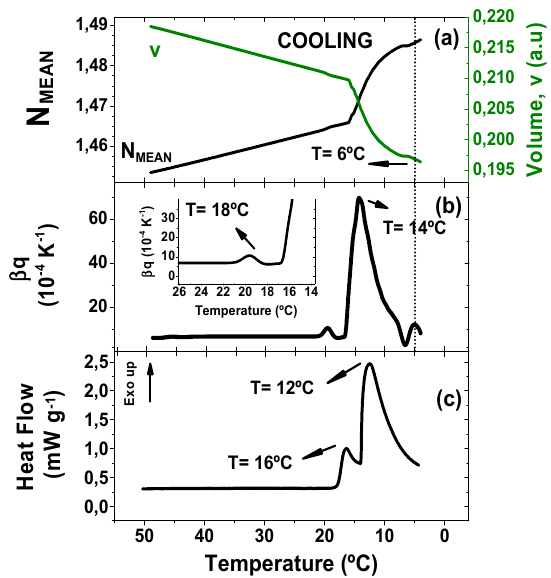
Figure 1. Comparison of the temperature dependence during cooling at 0.5 K min − 1 of ( a ) NMEAN and Volume (a.u.) recorded via TMOR with temperature modulation of 0.5 K amplitude and 17 mHz modulation frequency. ( b ) The thermal volume expansion coefficient β q (K − 1 ) recorded via TMOR with temperature modulation of 0.5 K amplitude and 17 mHz modulation frequency, and ( c ) heat Flow (mW g − 1 ) recorded via DSC.